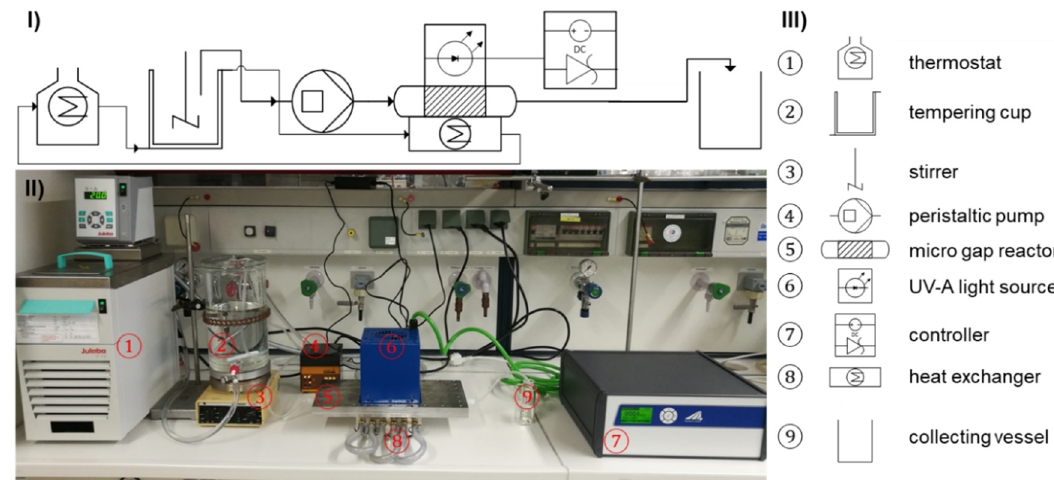
Figure 14. Overview of the microgap experimentation set up; ( I ) process flow diagram, ( II ) photograph of process implementation, ( III ) legend; glass frit for gas inlet not shown.